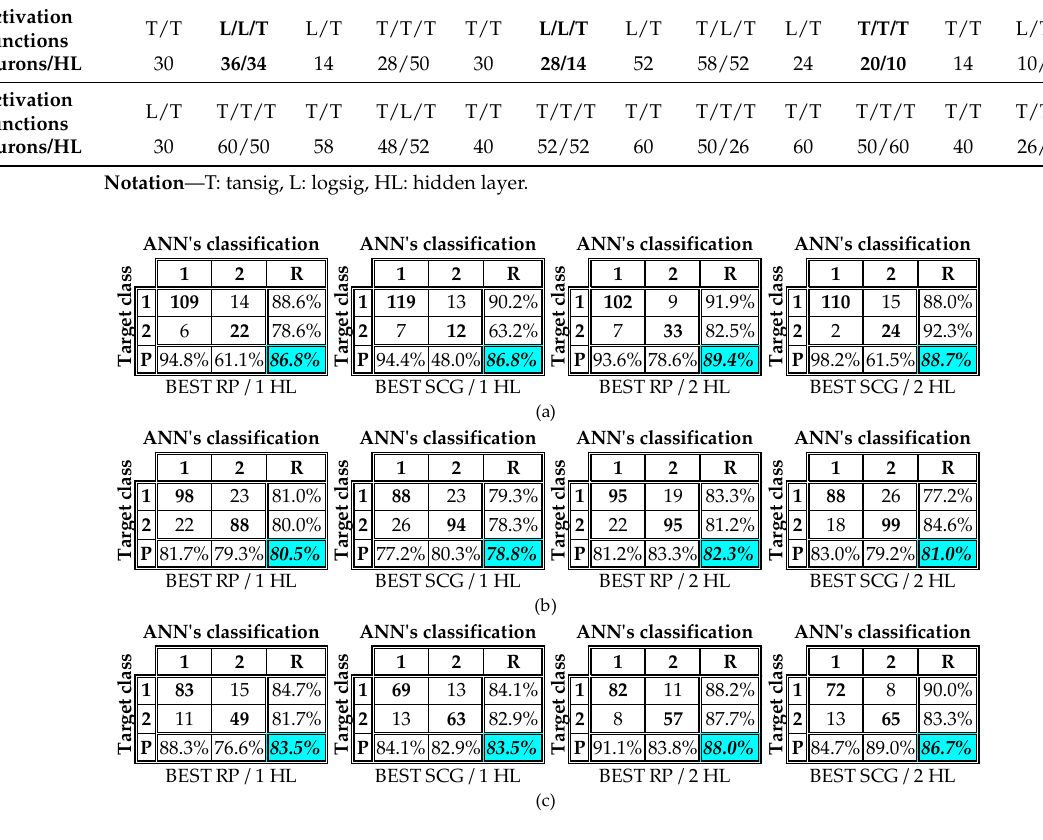
Figure 8. CMs according to the testing subsets extracted by the optimally configured NA1 networks: ( a ) BB; ( b ) RIB; ( c ) IIB.